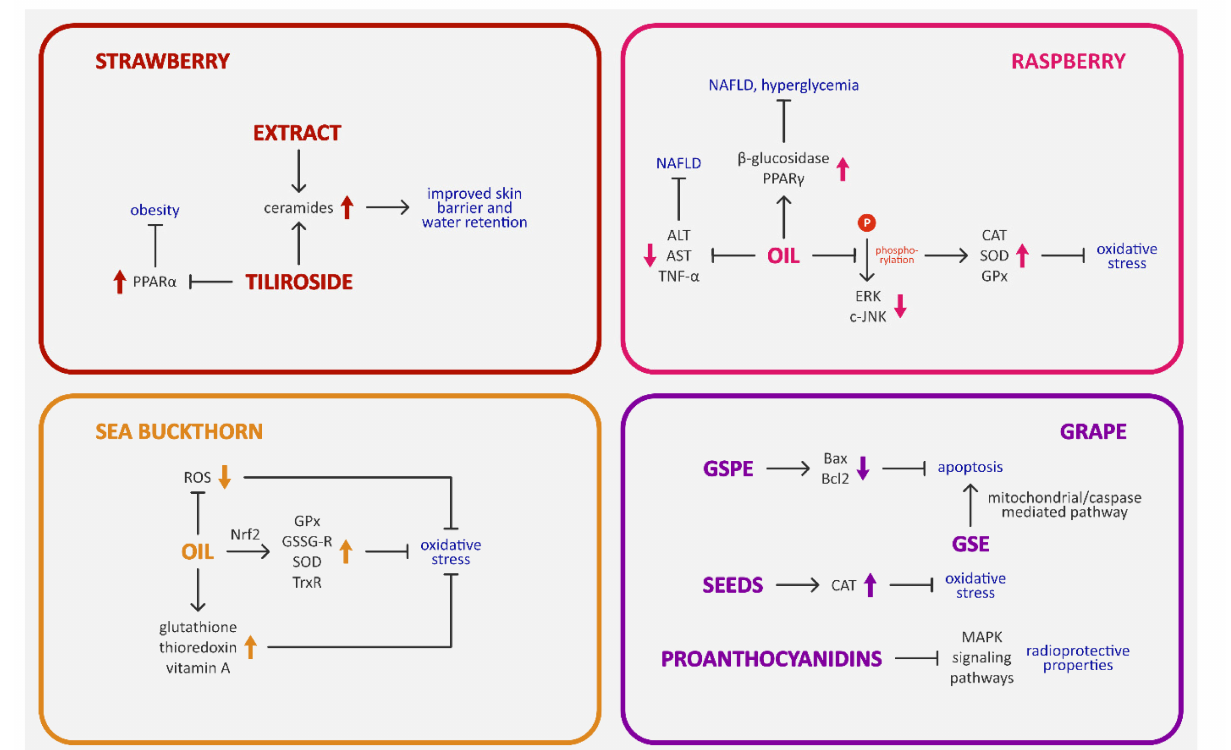
Figure 4. Selected signaling pathways involved in the activity of berry seeds and their health- promoting potential. ALT—alanine aminotransferase; AST—aspartate aminotransferase;